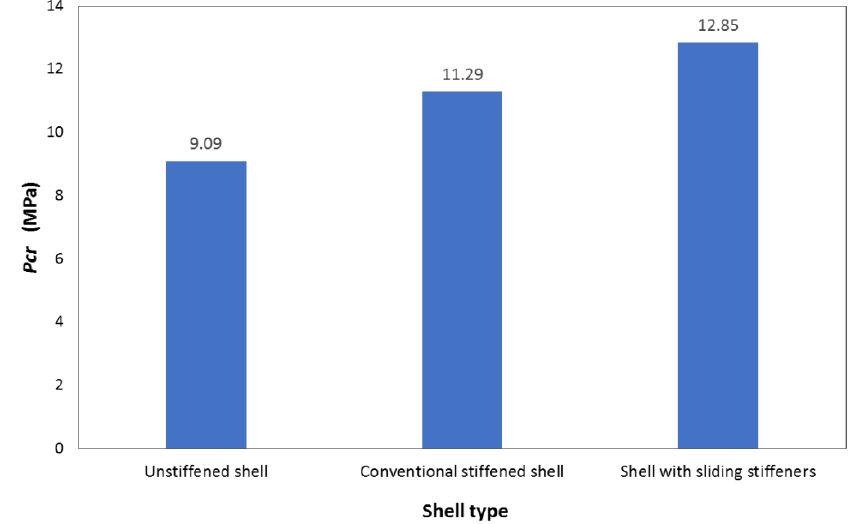
Figure 17. Critical pressures obtained by the finite element method for the three alternative shell